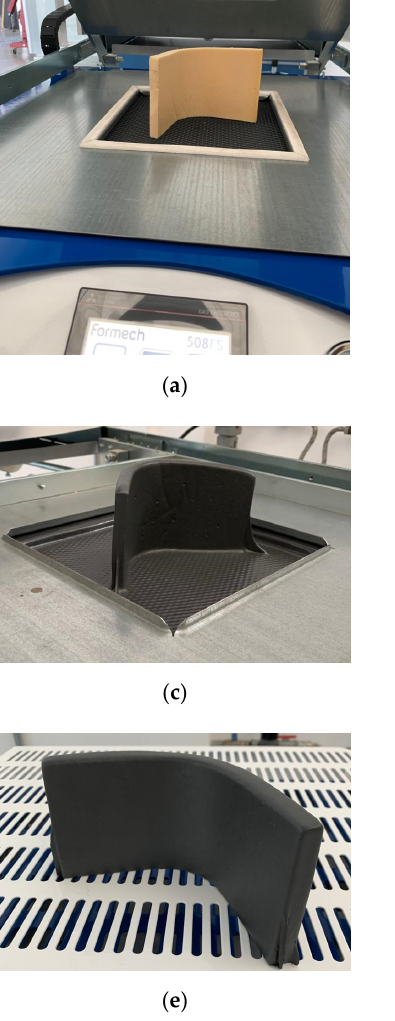
Figure 13. Schematic representation of the V ‐ shaped vacuum forming panels: ( a ) foam core lays on the work platform, ( b ) ABS sheet places in the reduced processing window, ( c ) ABS ‐ T/Foam/ABS ‐ T panel, ( d ) bottom of the vacuum forming panel, and ( e ) panel after removing the excess of material. The panel is covered with the ABS sheet.